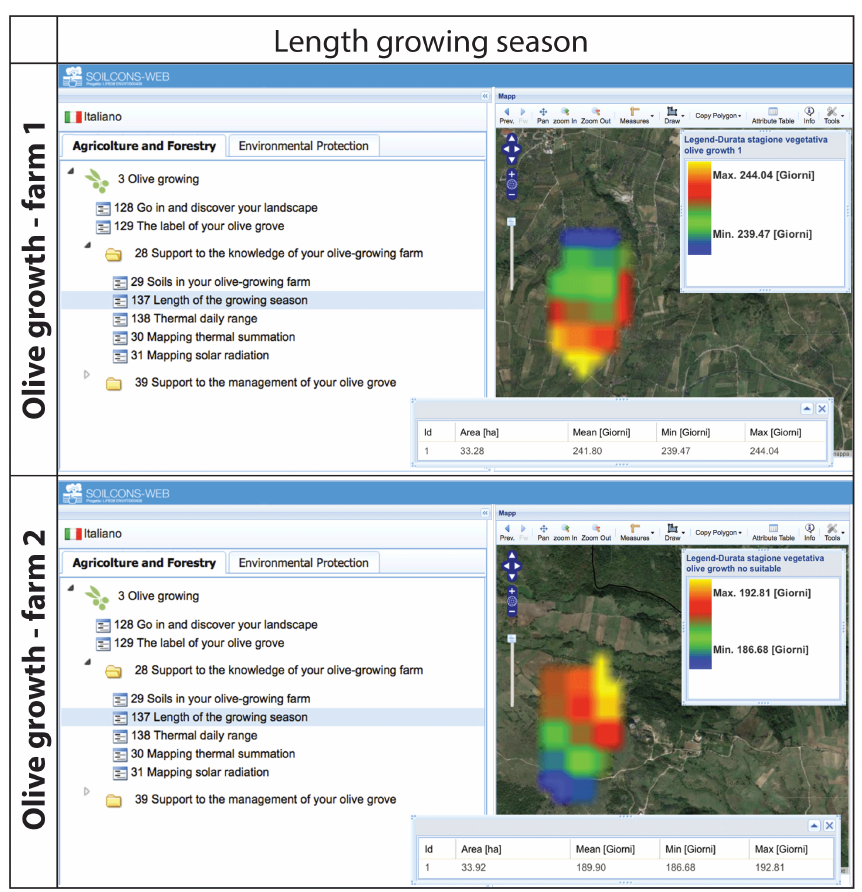
Figure 6. Output examples from the support for the olive growth tool: length of the growing season.